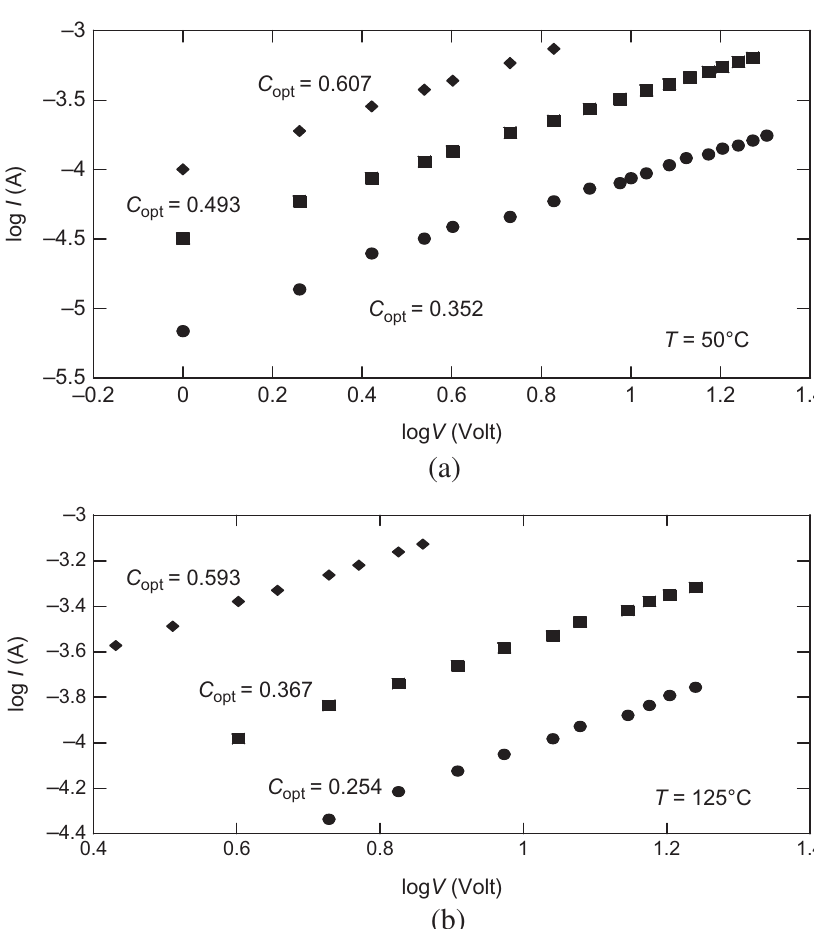
Figure 3: Log I vs log V at various C opt concentrations for two different substrate